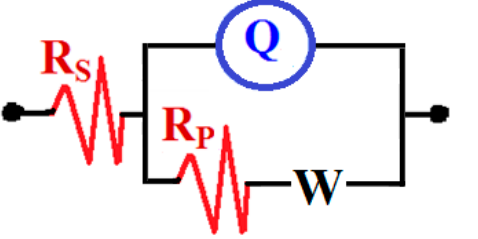
Figure 4. An equivalent circuit model to fit the electrochemical impedance spectroscopy (EIS) experiments shown in Figures 1–3.